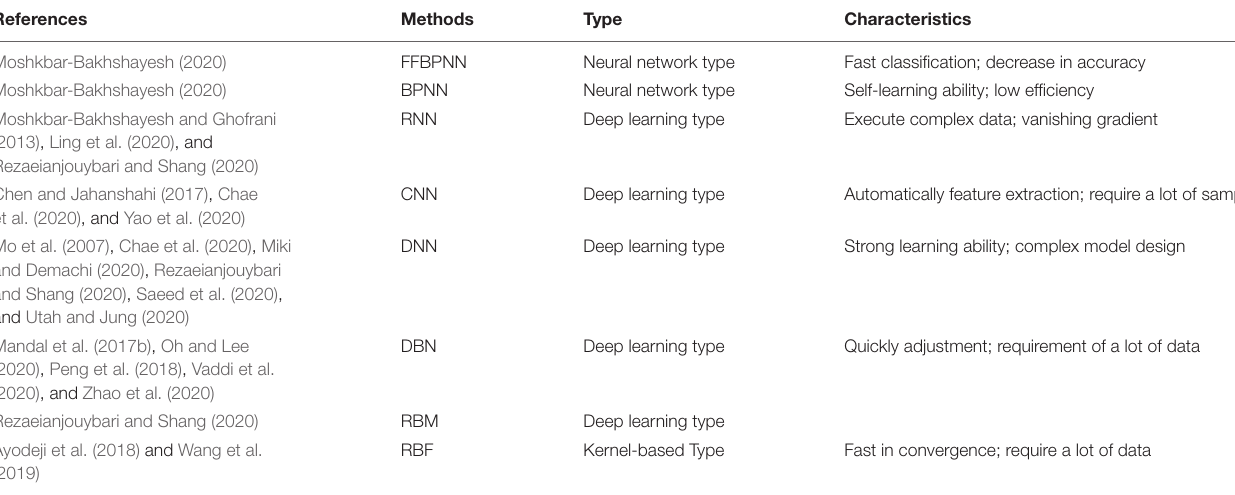
TABLE 3 | Status of the data-driven machine learning (DDML) of the algorithm type method for the fault diagnosis and detection (FDD) in the nuclear power plant (NPP).